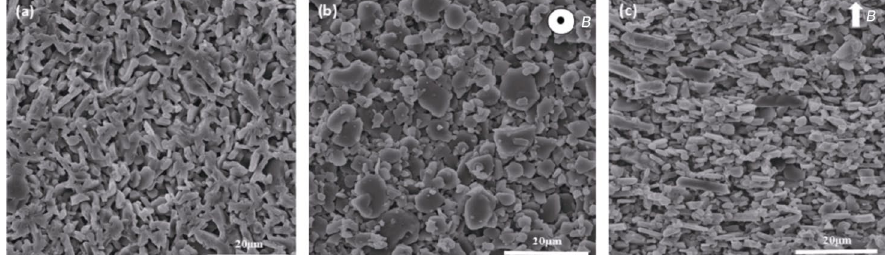
Fig. 22 Polished surfaces of untextured and textured α-Al 2 O 3 specimens: (a) untextured specimen; (b, c) textured specimen surfaces perpendicular and parallel to the magnetic field direction, respectively. Reproduced with permission from Ref. [69], © WILEY ‐ VCH Verlag GmbH & Co. KGaA, Weinheim